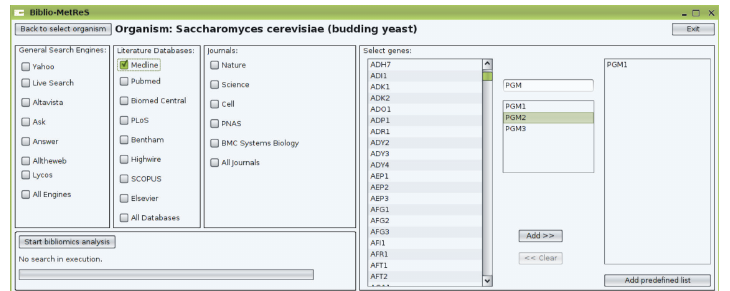
Figure 2: Bilio-MetReS . Main window.